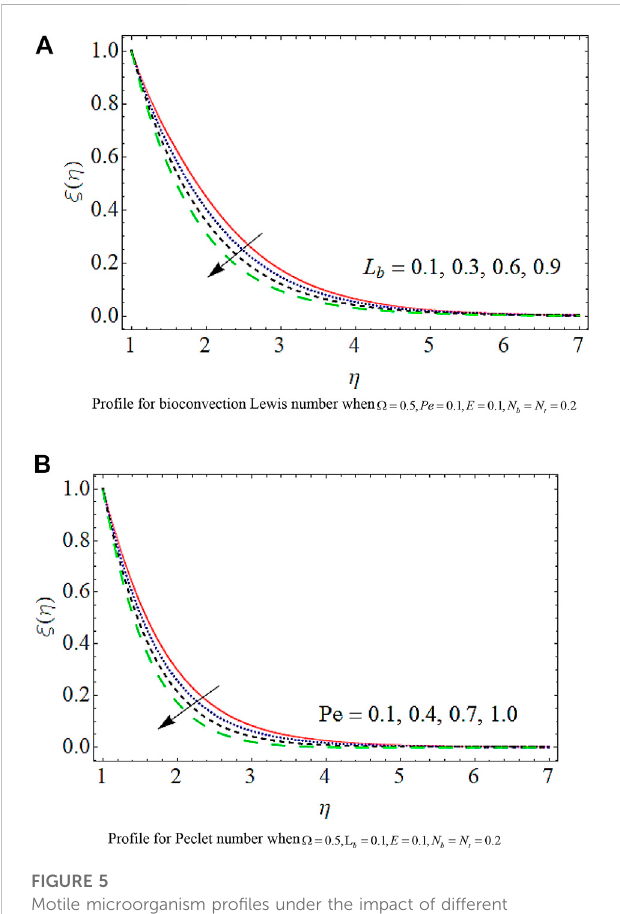
FIGURE 5 Motile microorganism pro fi les under the impact of different